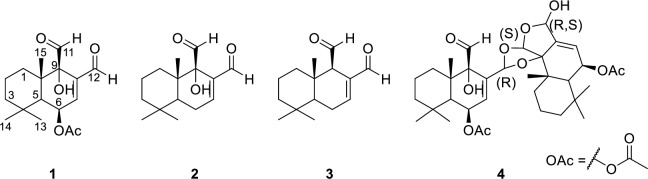
Chemical structures natural drimane-type compounds.Cinnamodial (1), warburganal (2), polygodial (3), capsicodendrin (4). Compounds 1, 3, and 4 have been isolated from C. fragrans.